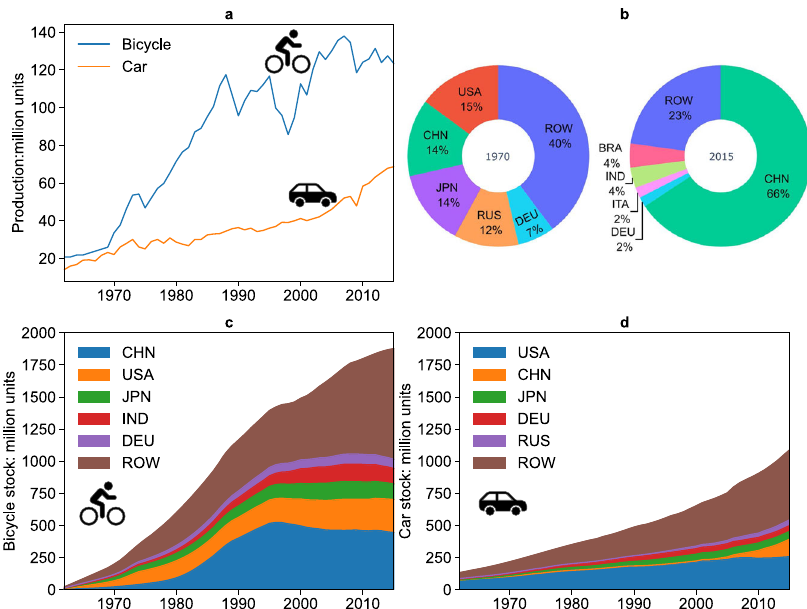
Fig. 1 Historical overview of global car and bicycle production and stock from 1962 to 2015. a Historical global production of car and bicycle from 1962 to 2015, b The share of global bicycle production in 1970 and 2015, c Bicycle stock from 1962 to 2015, d Car stock from 1962 to 2015. Bicycle refers to conventional human-powered ones only, while the car category includes all types of four-wheeled private vehicles such as small passenger cars, sports utility vehicles, and light trucks. The country codes are based on ISO 3166-1 alpha-3 code. ROW indicates the rest of